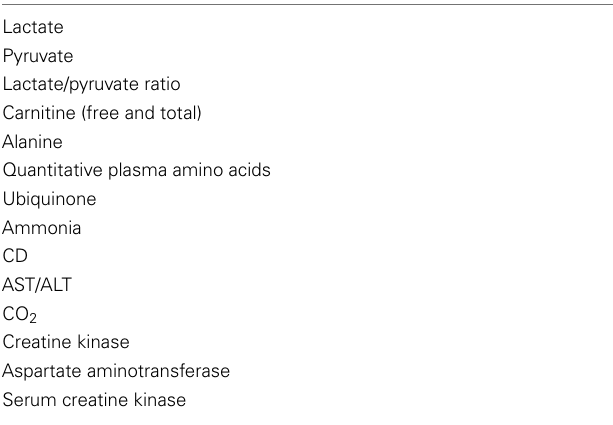
Table 3 | Mitochondrial function biomarkers inASD (see text for references)